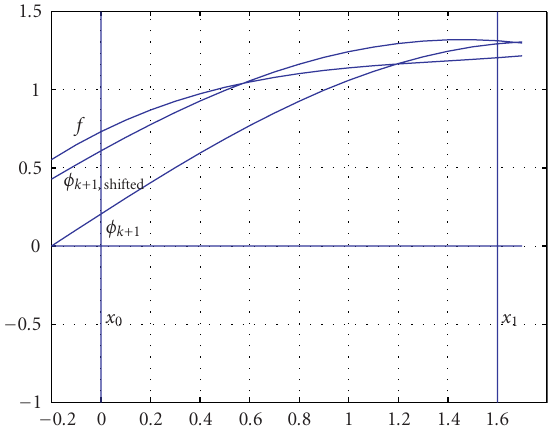
Figure 3.2. Construction for the proof of Lemma